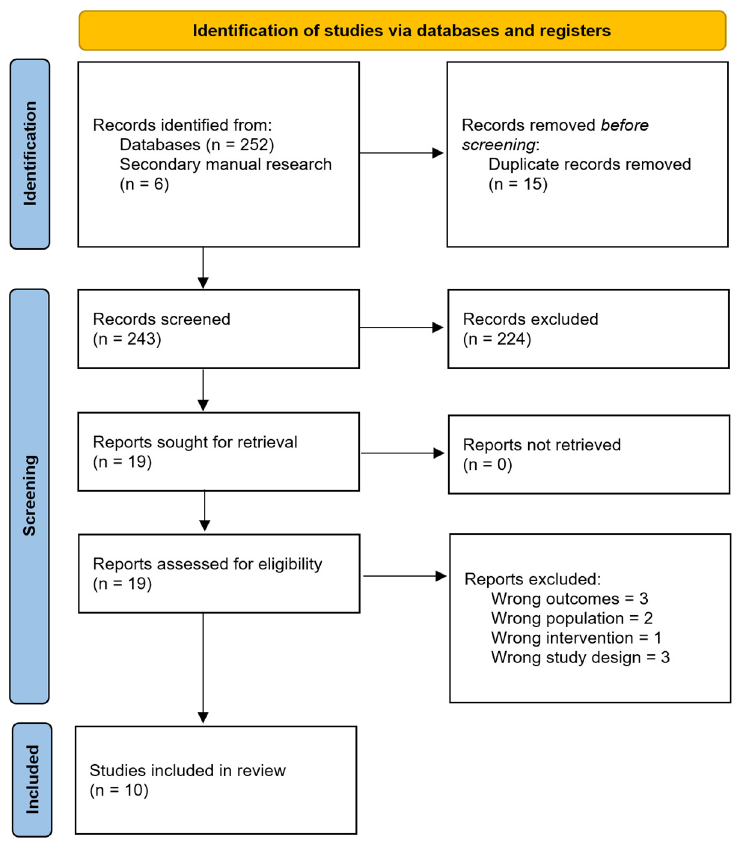
Figure 1. Systematic review flow chart. Table 3. Characteristics of the included studies.